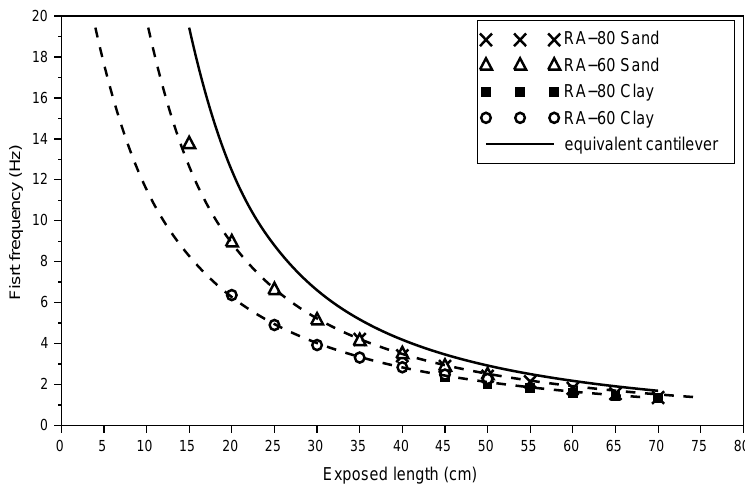
Figure 10. Equivalent cantilever of rectangular aluminium (RA) rod-sensors in sand and clayey soil: experimental first frequency for road-sensor RA-80 and RA-60 in both sand and clayey soil, and first frequency of equivalent cantilever beam f th =